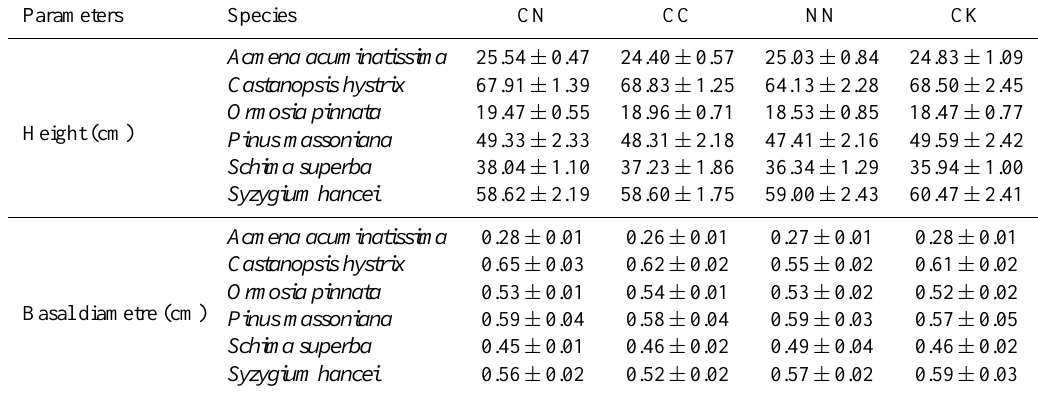
Table 1. Height and basal diameter of the plant seedlings among all treatments at the beginning of the experiment (mean ± standard devia- tions). The treatments are: CK = control, NN = high N, CC = elevated CO 2 , CN = elevated CO 2 + high